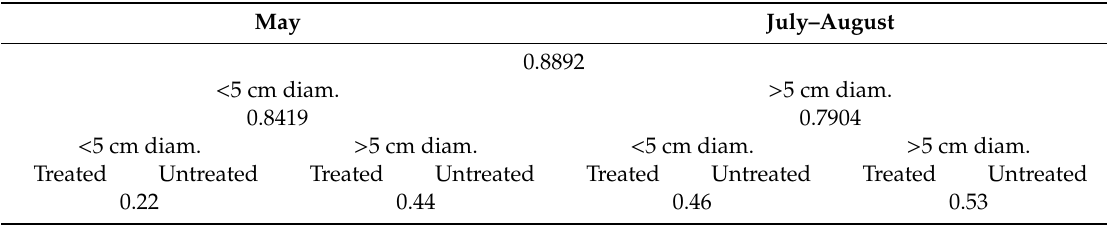
Table 2. Sørensen coe ffi cients of similarity (C N ) for comparing fungal communities from di ff erent stump sizes and with or without glyphosate